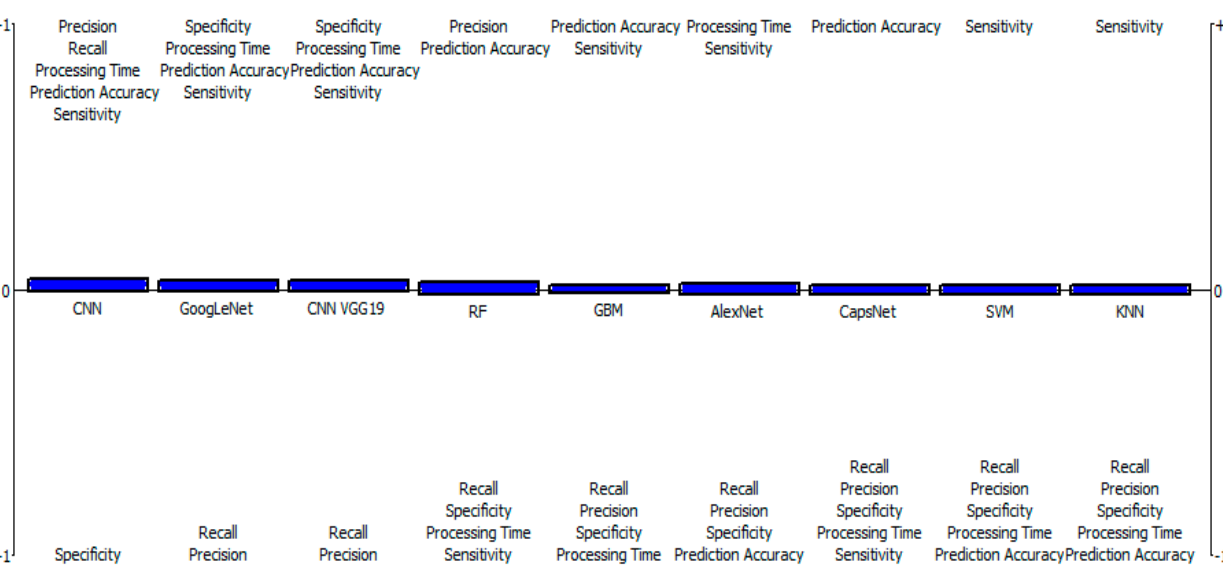
Figure 1. Fuzzy-based PROMETHEE results of positive and negative aspects of ML models.